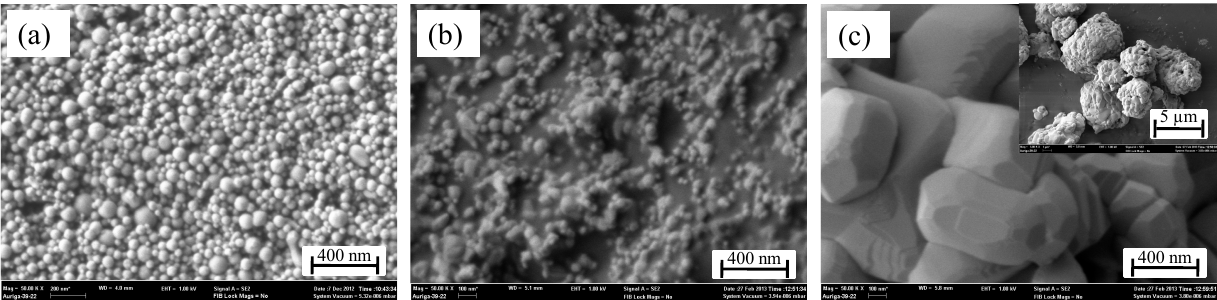
particles in ( a ) as-received condition; ( b ) heat treated 2